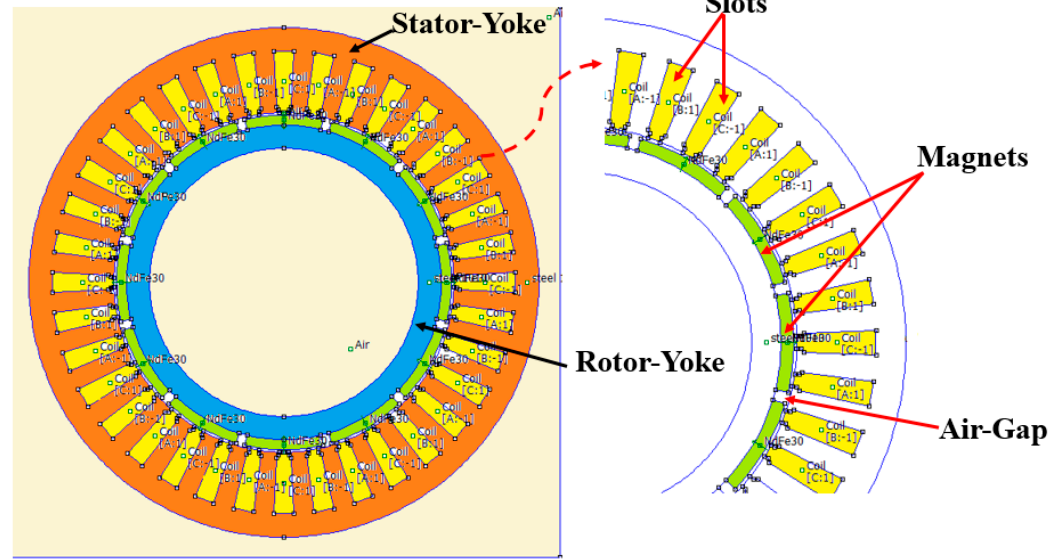
Figure 5. Permanent magnet synchronous generator structure with the 2D finite element analysis software, FEMM.